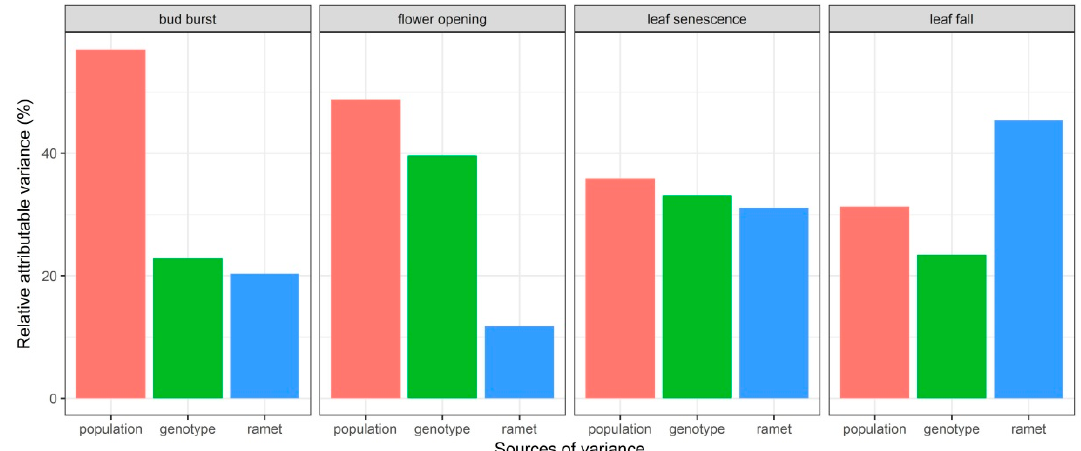
Figure 2. Variance components extracted from the mixed models for the four phenophases observed in the two common gardens. Relative variance is partitioned for populations (between populations), genotypes (between genotypes within populations) and ramets (between ramets within genotypes).